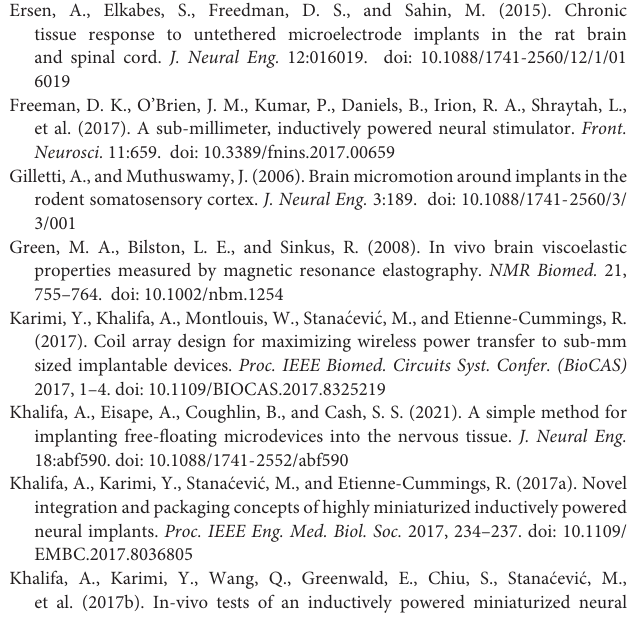
Supplementary Figure 1 | Table showing the number of microdevices injected for each animal and their location in the brain. Supplementary Figure 2 | Tracking microdevice migration in the rodent brain using a 9.4T MRI scanner. ( Top row ) Two close-up axial MR images of the rat (#4) brain taken at different post-injection times, one MR image created by superimposing one over the other, and one created by subtraction. Microdevice D2 was injected (encircled in yellow) into M1. ( Bottom row ) Two close-up axial MR images of the rat (#5) brain taken at different post-injection times: one MR image created by superimposing one over the other and one created by subtraction. Microdevice D1 was injected (encircled in yellow) into the corpus callosum. Supplementary Figure 3 | Picture of a tissue block following brain fixation in PFA and trimming. The injected microdevice is encircled in yellow. Supplementary Figure 4 | Examples of unsuccessful MR images of the rat brain affected by (left) gradient duty cycle issues and (right) motion artifact. Supplementary Figure 5 | GFAP immunoreactivity to the microdevice (left) and microelectrode (right). Tissue slices were taken from rat #5 at 17 weeks post-injection/implantation. The plots show the average fluorescence pixel intensity of GFAP as a function of distance from the edge of the microdevice or microelectrode. The blue dashed line represents the full width at half maximum